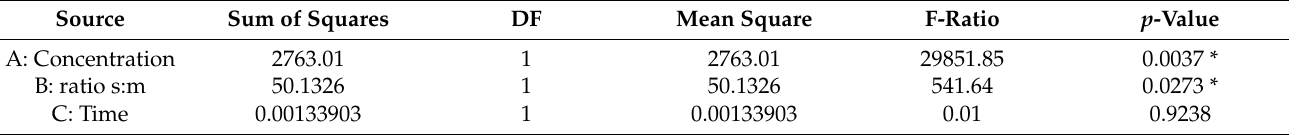
Table 3. Analysis of Variance for the moisture sieving test obtained in the OD process.